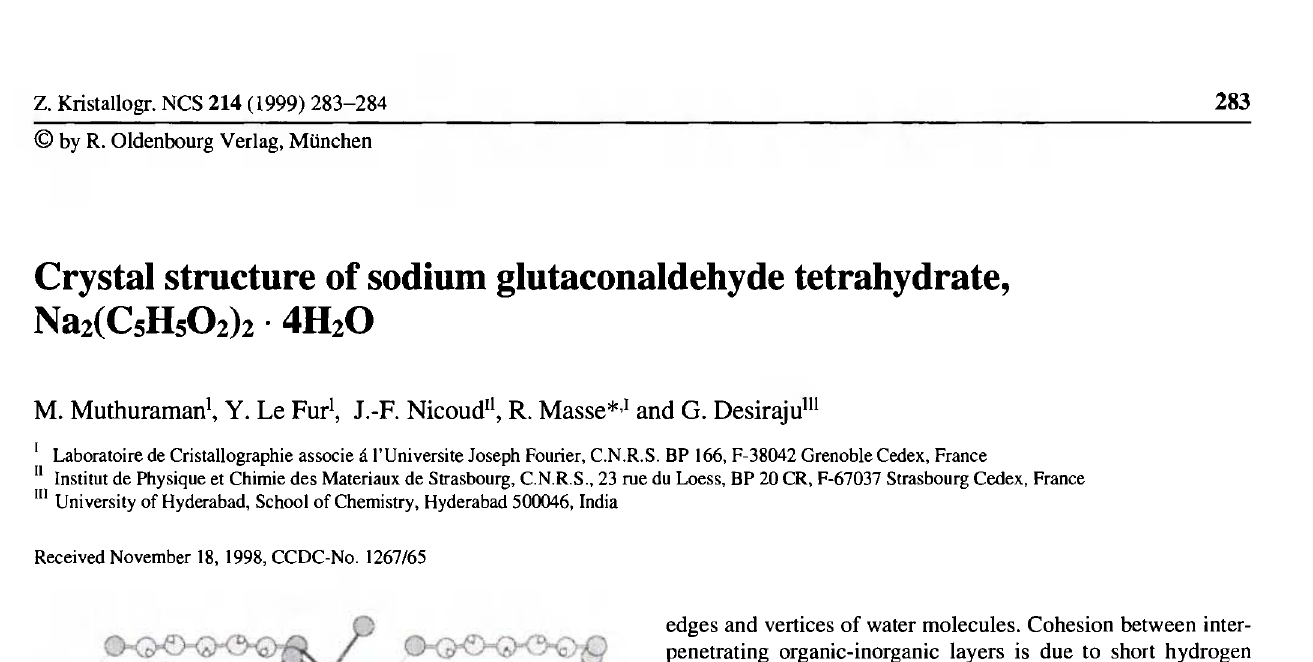
Table 1. Data collection and handling.